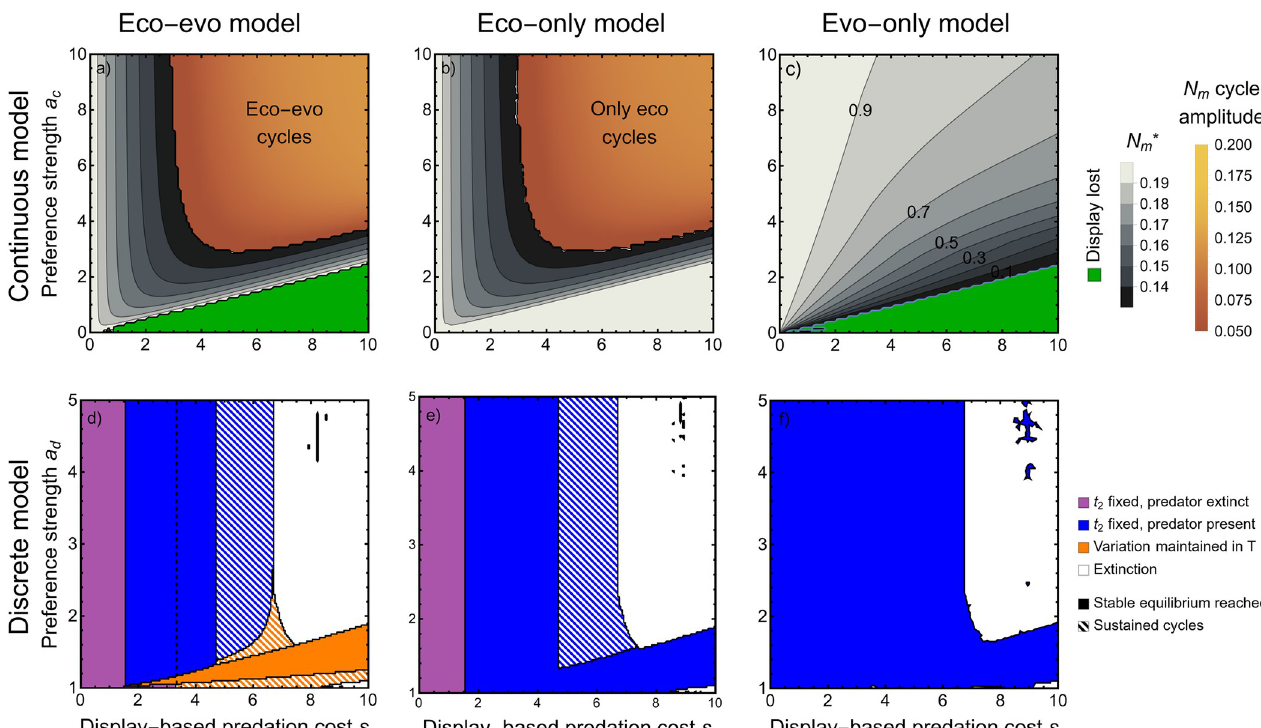
Fig 2. The role of eco-evolutionary dynamics as a function of preference strength and predation cost. Comparing to S1 Fig demonstrates the importance of eco-evolutionary dynamics in setting long-run density and trait values if one were to consider either model in isolation. ( a – c ) The continuous model with r 2, b c = 5, σ = 0.1, c c = 0.1, m = 0.1, t h = 0.5. ( a ) Equilibrium outcomes from the full, eco-evolutionary model. ( b ) Outcomes with only predator–prey dynamics. ( c ) Outcomes with only sexual selection. Green indicates that the sexual display is lost. Gray indicates that a stable equilibrium is reached. For ( a , b ), gray contours correspond to equilibrium male prey density N m * (see legend). For ( c ), gray contours correspond to the mean display trait value at equilibrium (compare to Fig 3). Yellow-orange indicates sustained cycles, with the shading giving the amplitude of the male prey’s cycle (see legend), which correlates with period and the amplitude cycles in all other variables (S2 Fig). Note that, although subtle, cycles in the purely ecological model are higher amplitude (lighter shading). ( d – f ) The discrete model with r d = 5, b d = 15, c d = 0.1. ( d ) Equilibrium outcomes from the full, eco-evolutionary model. Purple indicates the sexual display fixes and predators go extinct. Blue indicates the sexual display fixes and predators persist. Orange indicates variation is maintained in the sexual display. White indicates extinction. Solid regions correspond to reaching a stable equilibrium, striped regions indicate sustained cycles. ( e ) Outcomes with only predator–prey dynamics (blue means the predator persists). ( f ) Outcomes with only display evolution (blue means the display fixes). That ( b ) is much more similar to ( a ) (and e to d ) than is true in S1 Fig indicates that ecological interactions are altered in the full eco-evolutionary model due to the way that densities and trait values are set, not just due to eco-evolutionary feedbacks per se. In contrast, that ( c ) is comparably different from ( a ) as in S1 Fig indicates that eco- evolutionary feedbacks per se are also responsible for altering evolutionary outcomes. This Figure can be generated using S1